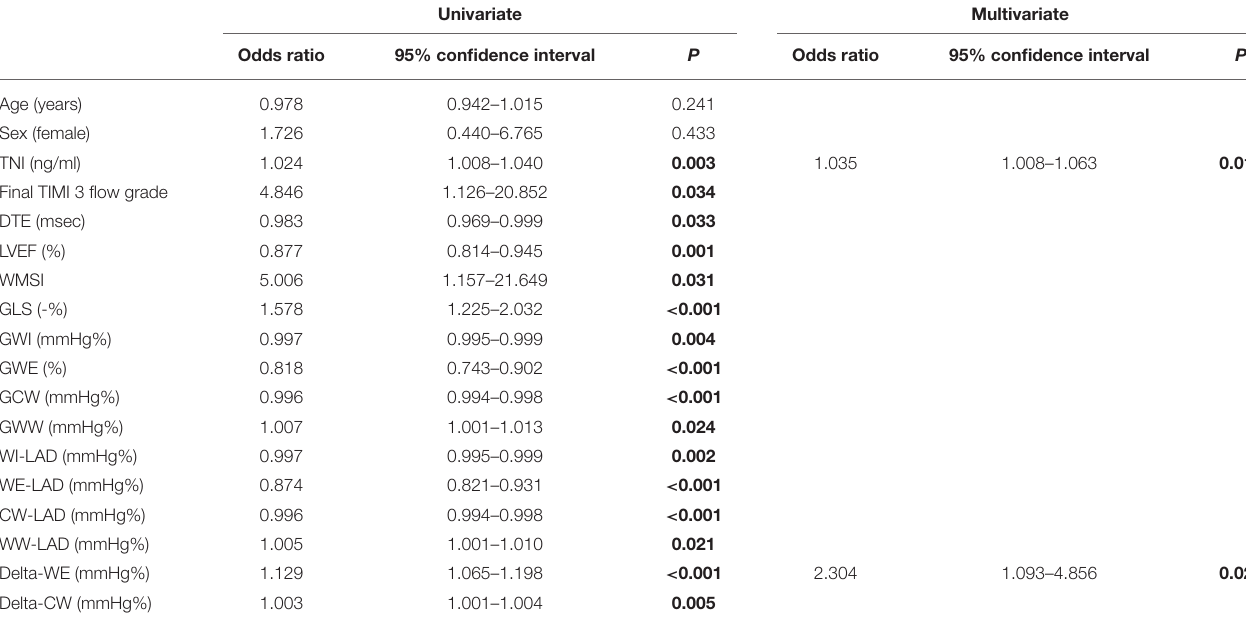
TABLE 4 | Uni- and multivariate logistic regression analysis for identifying predictors of early LV remodeling.